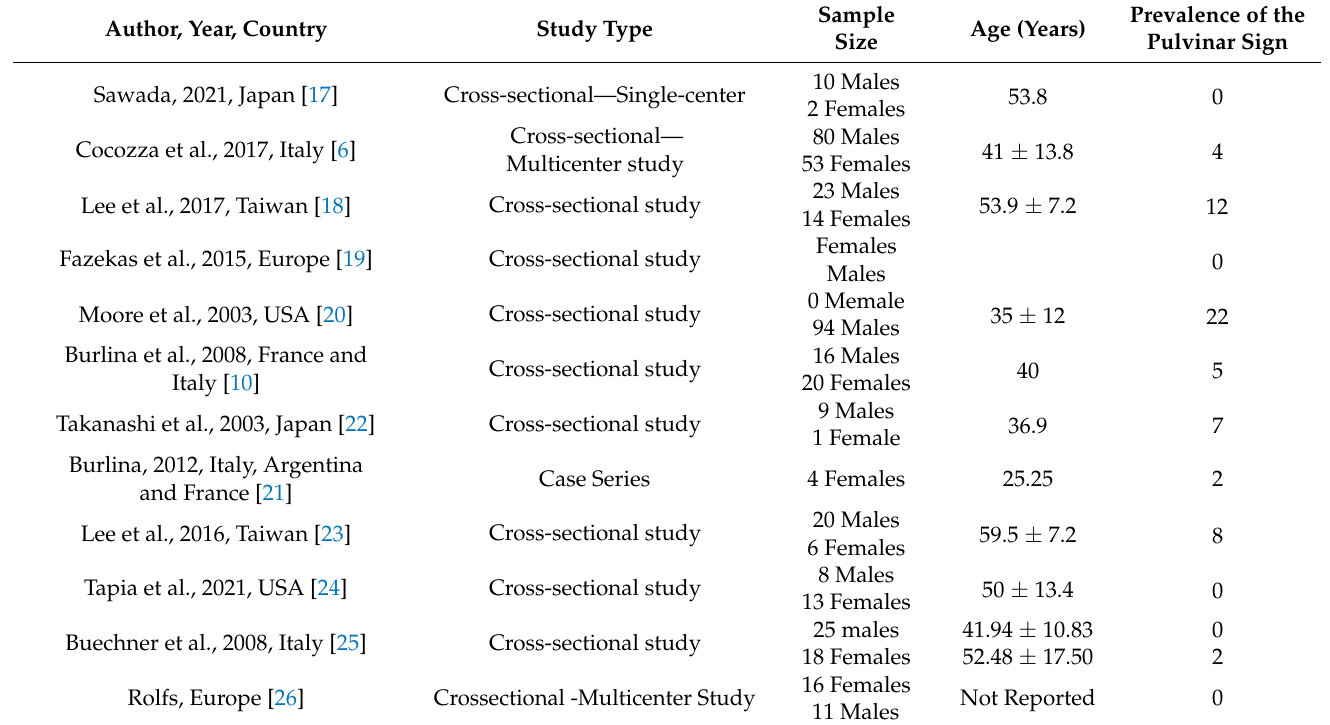
Table 1. The characteristics of the studies included in the metanalysis.